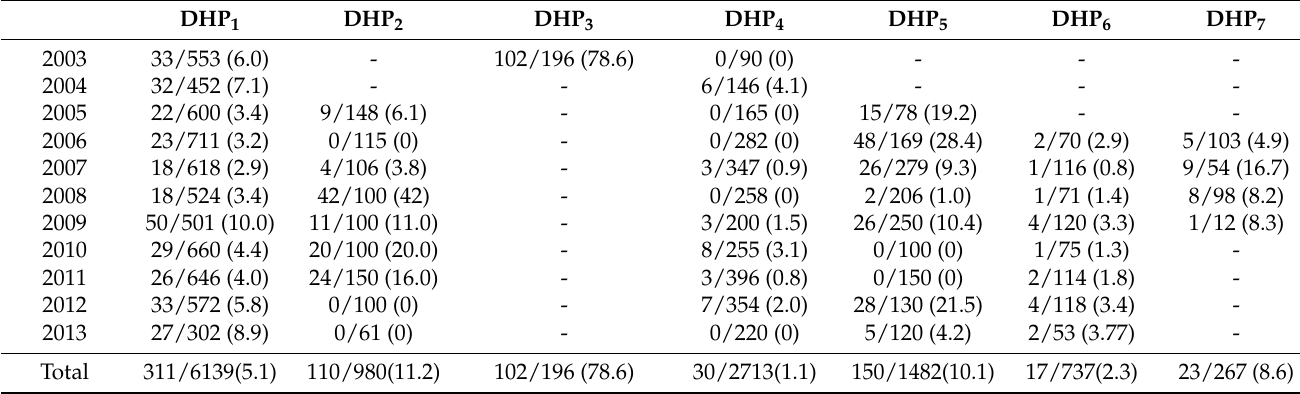
Table 1. Number of influenza A virus isolates/number of samples collected (%) annually in each duck hunting preserve